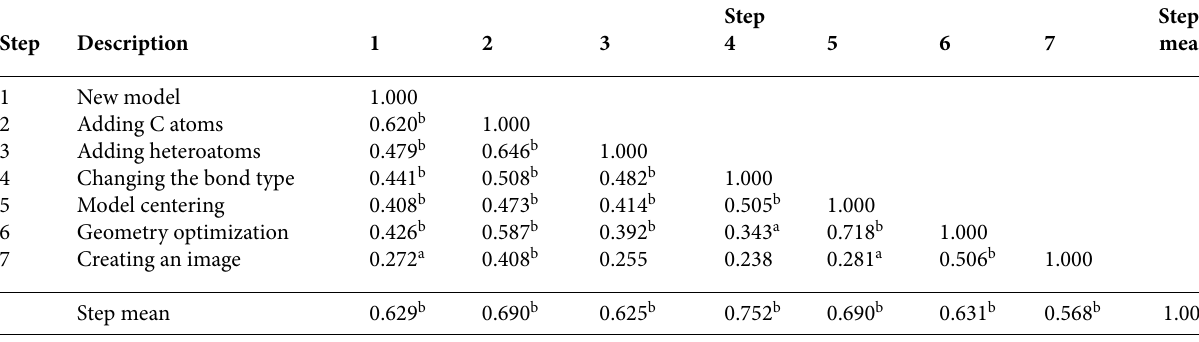
Table 10: Spearman correlations between step difficulty levels within Activity 1